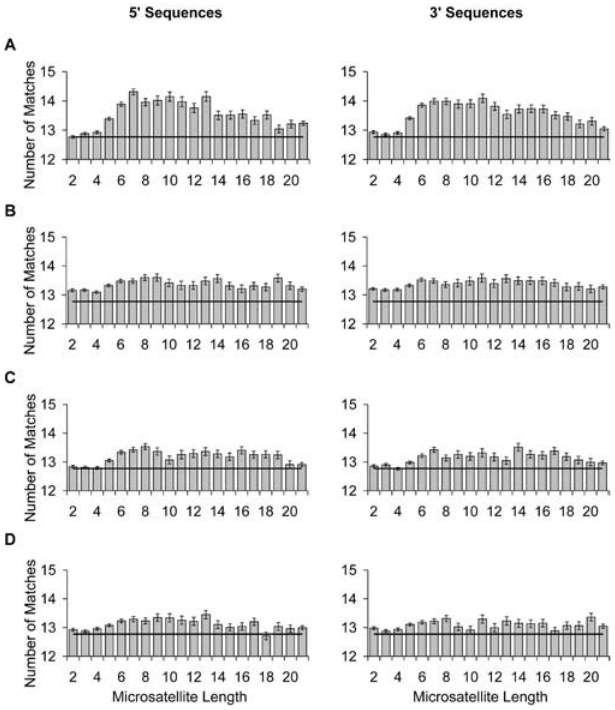
Figure 9. Dependence of Sequence Similarity among Flanking Sequen- ces on AC Repeat Number The average number of matches shown ( 6 standard error) quantifies similarity among three classes of sequence: (1) blocks of 50 bp lying immediately adjacent to a microsatellite; (2) blocks of 50 bp chosen randomly to lie between 500 and 600 bases downstream from a microsatellite; and (3) randomly selected blocks of 50 bp from around the genome. Average level of chance similarity in the genome is shown by a black line in each plot (comparison among class 3). 5 9 and 3 9 sequences are shown separately. Comparisons among sequence classes are shown for class 1 to class 1 (A), class 1 to class 2 for sequences at the same locus (B), class 1 to class 2 for sequences at different loci (C), and class 1 to class 3 (D). DOI: